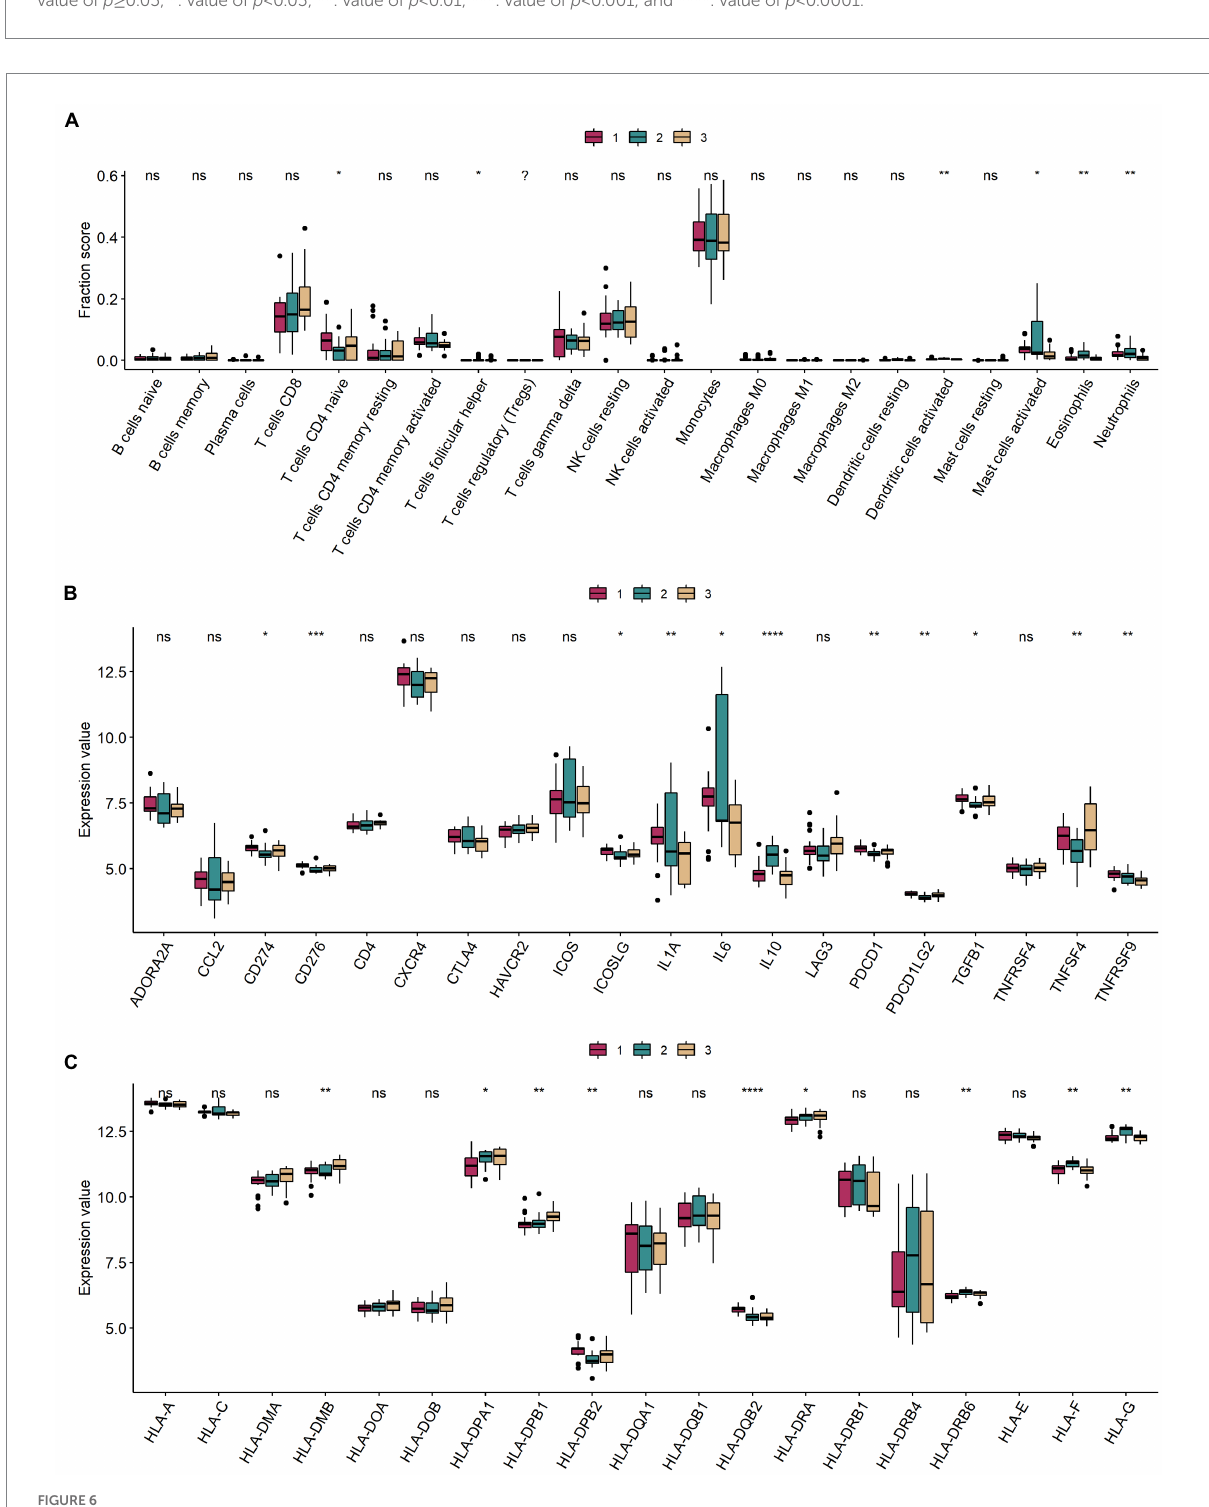
FIGURE 6 Immune microenvironment between different m6A modification classes. (A–C) Boxplots of immune infiltrating cells, immune-related genes, and HLA-related genes in different m6A modification classes. ns: value of p ≥ 0.05; *: value of p < 0.05; **: value of p < 0.01; ***: value of p < 0.001; and ****: value of p <